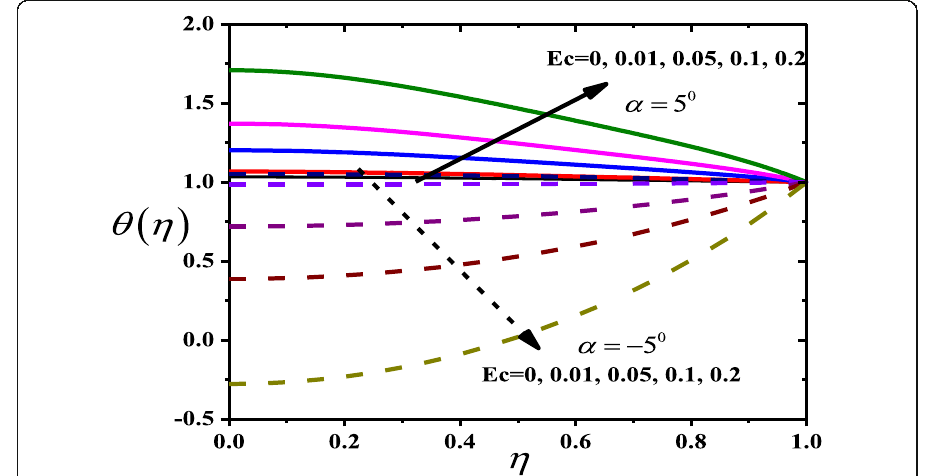
Fig. 11 Temperature vs. Ec in shrinking divergent and stretching convergent